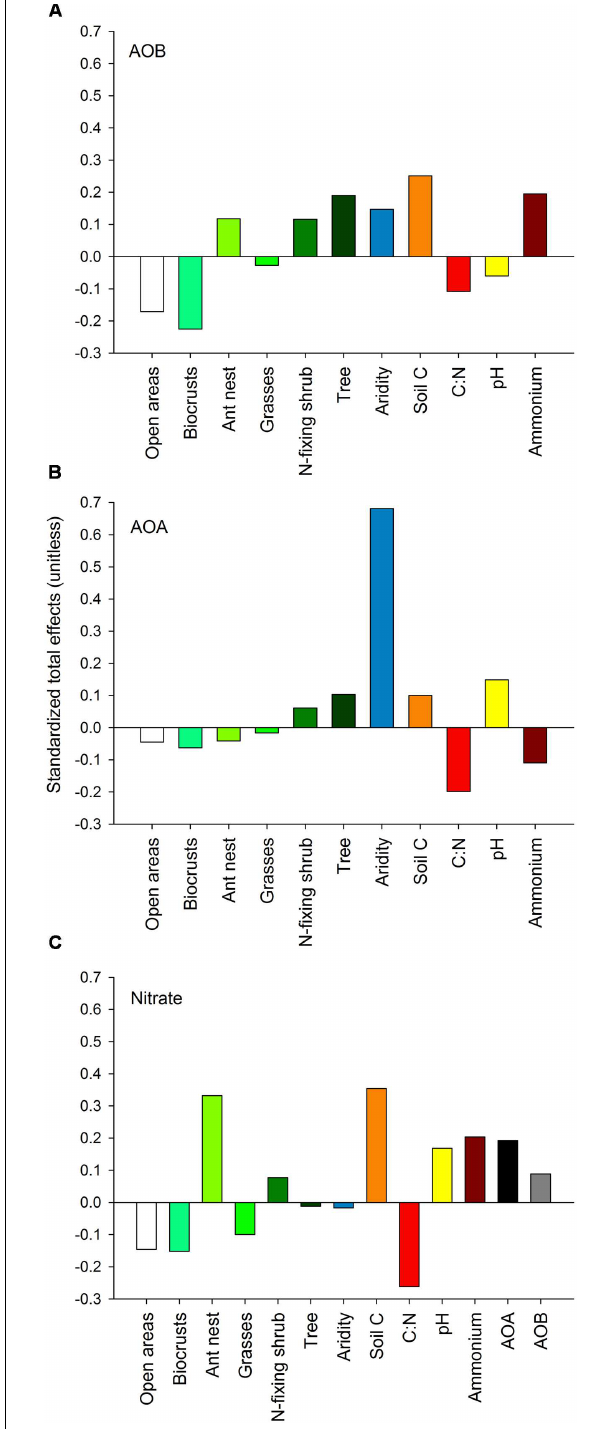
Frontiers in Microbiology |